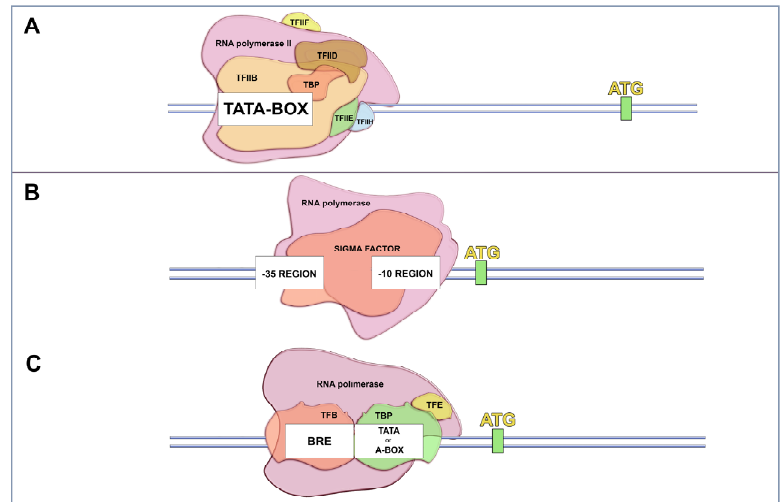
Figure 1. Main features in the transcription initiation machinery presented in the canonical Domains of Life. ( A ) In Eukarya, several components, called general transcription factors (represented as TFIIB, TFIID, TFIIE, TFIIF, TFIIH and TBP), are responsible for assembling over a region called the promoter, where they recruit an RNA polimerase to initiate the transcription process. A classical promoter presented in this group is the TATA ‐ BOX region, located at the positions − 25 and − 30 from the initial transcription site; ( B ) In Bacteria, the sigma factor recognizes and recruits the RNA polimerase over the promoter regions. These regions are well conserved over the positions − 35 and − 10 upstream of the initial transcription site; ( C ) Archaea present a mixture of the transcription apparatus of the two other Domains. While the machinery itself is similar to that found in eukaryotes (the general transcription factors, a homologous TATA ‐ BOX region and the RNA polimerase), the archaeal transcription regulators, activators and repressors are homologous to the bacterial ones.